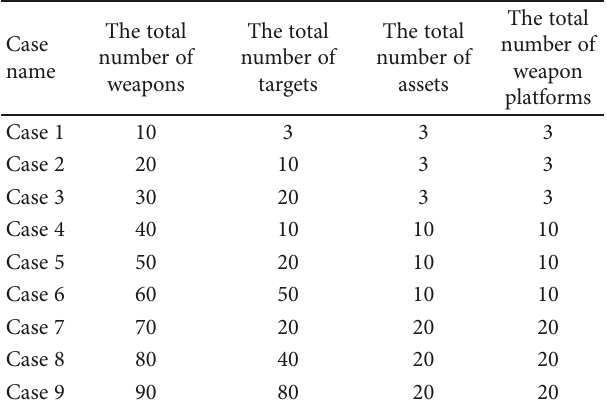
Table 1: The generated